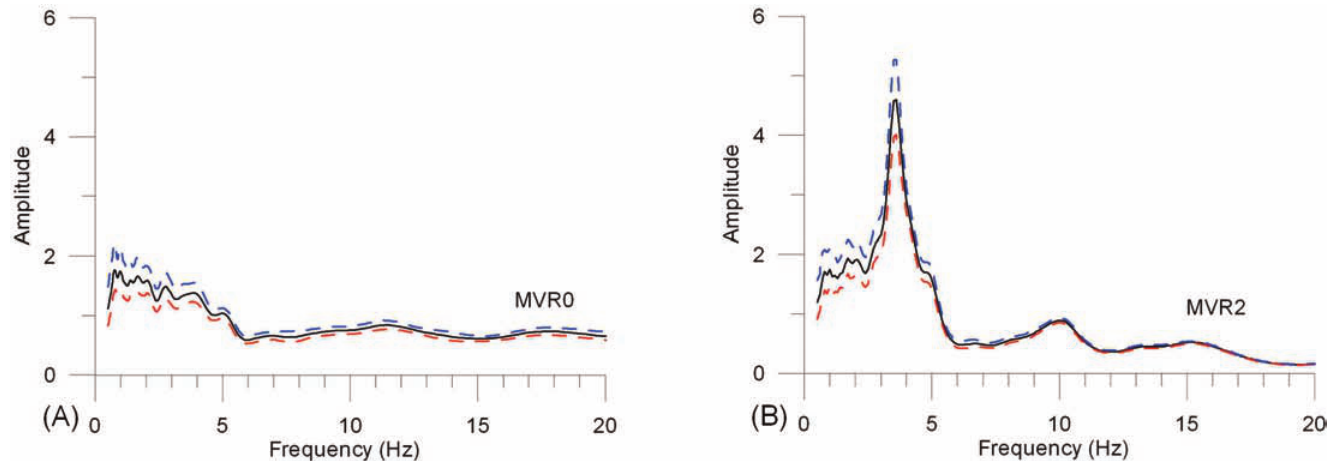
Figure 6. H/V spectral ratio curves for station MVR0 (A) and for station MVR2 (B). Black continuous lines, mean values of the curve. Blue and red dashed lines, standard deviations over the whole period